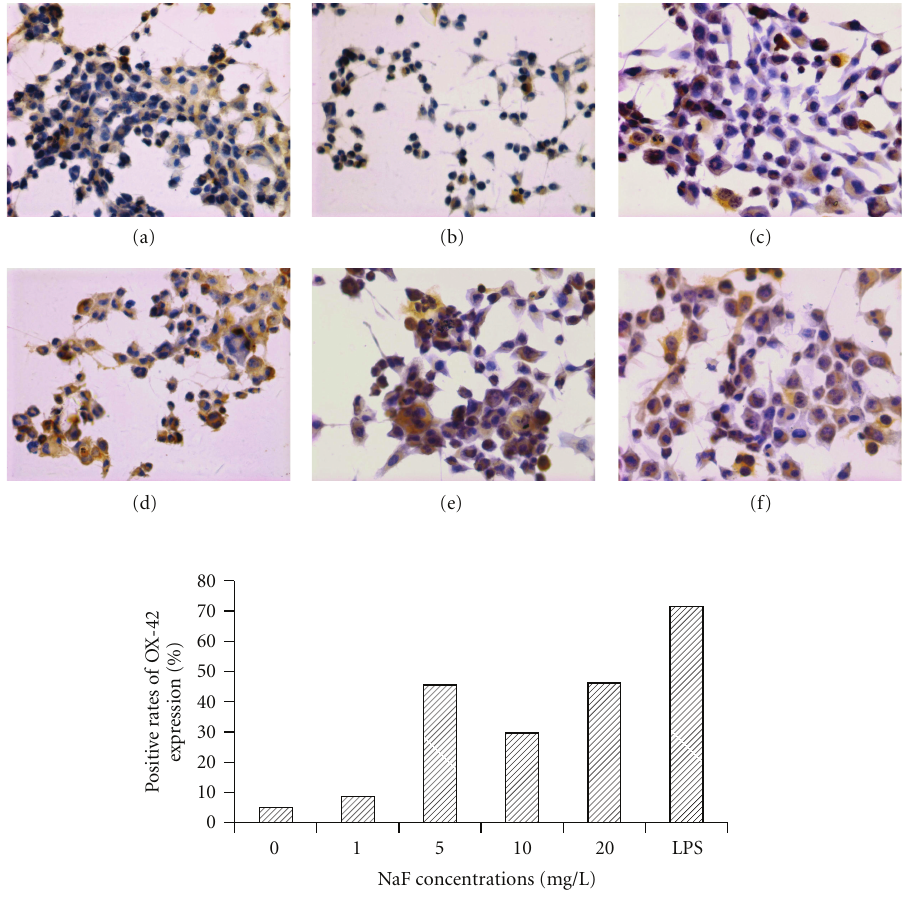
Figure 2: The activity of microglial BV-2 cells induced by fluoride. Cells were treated with indicated concentrations of NaF for 24 h and immunocytochemistry localization with an OX-42 antibody as a microglial marker were observed. Microglial activity was detected by OX- 42 expression, and the microglia cells treated with LPS were used as a positive control. Morphological changes of microglia from the resting state ((a) small cell bodies and thin, long, or ramified processes) to the activated state ((c), (d), (e), (f) larger cell bodies with short, thick) were observed after fluoride or LPS treatment in the BV-2 cells. High expression areas of OX-42 immunoreactivity were indicated by arrows. Optic microscopy: HE (400 × ). (a) control, (b) 1 mg/L NaF, (c) 5mg/L NaF, (d) 10 mg/L NaF, (e) 20 mg/L NaF, and (f) 100ng/mL